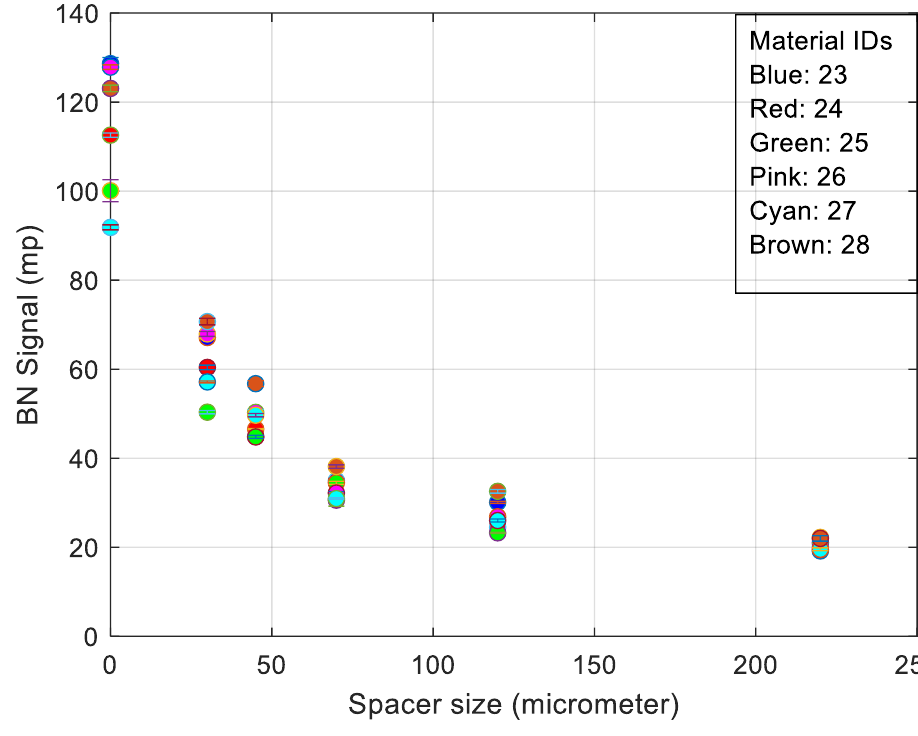
Figure 4. BN signal response for bottom surface in transversal orientation.